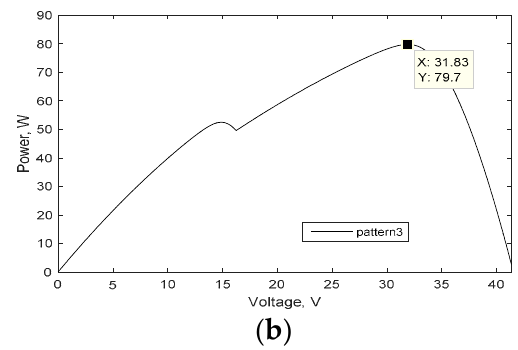
Figure 7. Characteristics of PV panel for pattern 2: ( a ) P-V, ( b ) I-V.